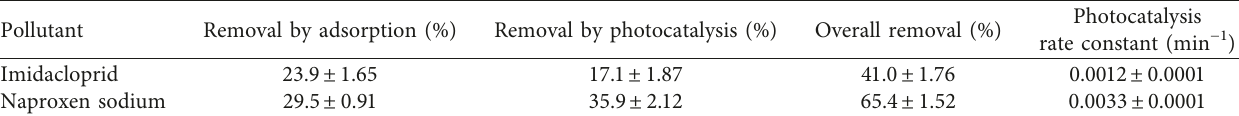
Figure 9: Adsorption and photodegradation of (a) naproxen sodium and (b) imidacloprid. (c) Comparing the adsorption and photo- degradation of imidacloprid and naproxen sodium by the Fe-TiO 2 -HNT composite. Table 1: Summary of the adsorption and photodegradation